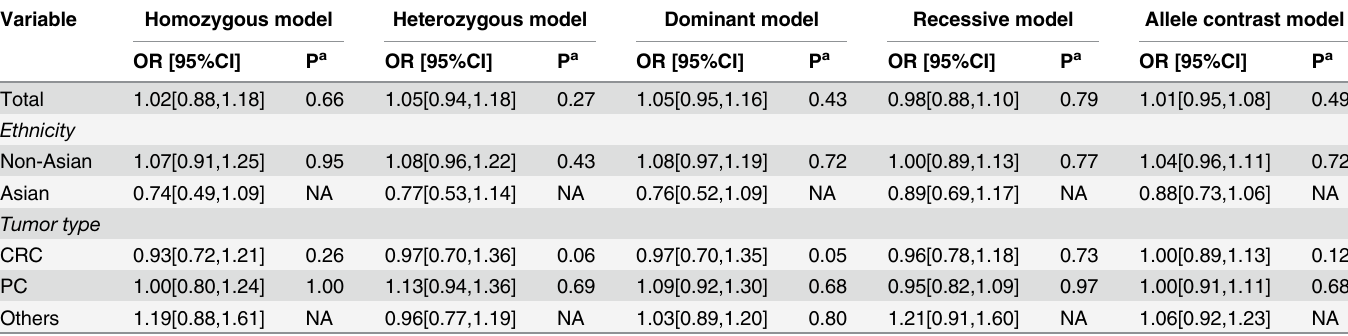
Table 3. Overall and subgroup analysis of the ADIPOR1 rs7539542(C/G) polymorphism and cancer risk.